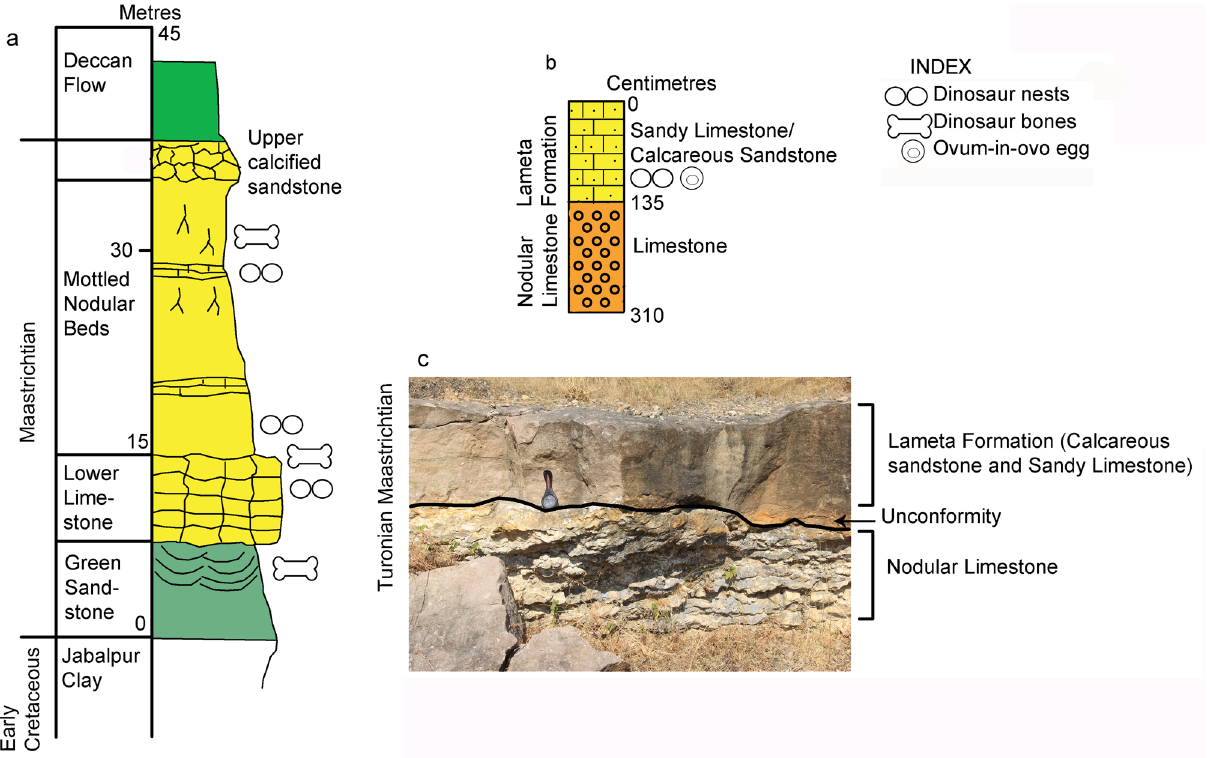
Figure 3. Stratigraphic subdivisions of the Lameta Formation; ( a ) Jabalpur (modified after Tandon et al. 41 ); ( b ) Padlya; ( c ) Field photograph showing the sandy limestone/calcareous sandstone of the Lameta Formation overlying the Nodular Limestone of the Bagh Group within Dinosaur Fossil National Park (DFNP), near Padlya, Dhar district, M.P. The Nodular Limestone (Bagh Beds) shows lensoid character while the sandy limestone/ calcareous sandstone has massive appearance ( a , b drawn using software Adobe Photoshop